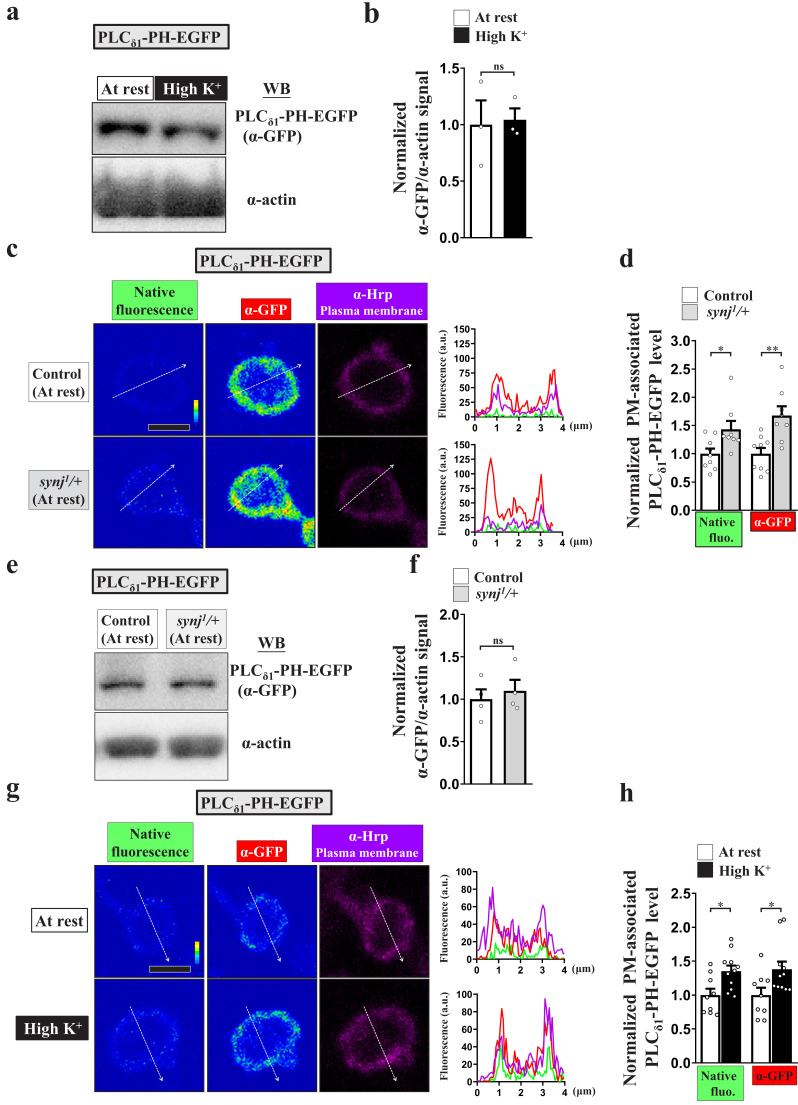
The change in PLCδ1-PH-EGFP fluorescence is responsible for an increase in the PI(4,5)P2 level.(a–b) The protein expression level of PLCδ1-PH-EGFP was not changed upon high K+ stimulation. (a) Larval fillets expressing UAS-PLCδ1-PH-EGFP using nSyb-GAL4 were dissected, and the brain and ventral nerve cord were removed. The samples were subjected to the resting condition (10 min incubation of 5 mM K+/0 mM Ca2+) or high K+ stimulation (10 min stimulation of 90 mM K+/2 mM Ca2+), and then immediately lysed in 1x SDS sample buffer. The lysate of a single larva was loaded in each lane of the western blot, and α-GFP and α-actin were used to detect presynaptic levels of PLCδ1-PH-EGFP or to serve as loading control, respectively. (b) Quantification data for the ratio of α-GFP to α-actin blotting signal, normalized to the value of the resting condition. (c–f) Reducing Synj levels increased the levels of PI(4,5)P2 and thus association of PLCδ1-PH-EGFP on the plasma membrane, but it did not increase the protein expression level of PLCδ1-PH-EGFP in synaptic boutons. (c–d) Single-plane confocal images of NMJ boutons neuronally expressing UAS-PLCδ1-PH-EGFP using nSyb-GAL4 in the wild-type control or synj1/+ lines. The boutons were subjected to the resting condition (10 min incubation of 5 mM K+/0 mM Ca2+), followed by chemical fixation and α-GFP immunostaining. Line plot profiles of absolute fluorescence units (a.u.) of native fluorescence or α-GFP immunostaining signal of PLCδ1-PH-EGFP are shown at right. α-Hrp immunostaining was used to outline the presynaptic plasma membrane. (d) Quantification data for the plasma membrane-associated PLCδ1-PH-EGFP fluorescence or immunostaining intensities, normalized to the value of wild-type boutons. (e–f) Brain-removed larval fillets expressing PLCδ1-PH-EGFP were subjected to western blot using α-GFP and α-actin antibodies. Quantification data for the ratio of α-GFP to α-actin blotting signal, normalized to the value of the wild-type control fillets (f). (g–h) High K+ stimulation elevated plasma membrane localization but not protein expression level of PLCδ1-PH-EGFP. (g) Single-plane confocal images of NMJ boutons neuronally expressing UAS-PLCδ1-PH-EGFP using nSyb-GAL4. The boutons were subjected to the resting condition (10 min incubation of 5 mM K+/0 mM Ca2+) or high K+ stimulation (10 min stimulation of 90 mM K+/2 mM Ca2+), followed by chemical fixation and α-GFP immunostaining. Line plot profiles of absolute fluorescence units (a.u.) of native fluorescence or α-GFP immunostaining signal of PLCδ1-PH-EGFP are shown at right. α-Hrp immunostaining was used to outline the presynaptic plasma membrane. (h) Quantification data for the plasma membrane-associated PLCδ1-PH-EGFP fluorescence or immunostaining intensities, normalized to the value of the resting condition. Individual data values are shown in graphs. p values: ns, not significant; *p<0.05; **p<0.01. Mean ± SEM. Scale bar: 2 µm (c, g). Statistics: Student t-test.
Figure 1—figure supplement 1—source data 1.Source data for Figure 1—figure supplement 1.